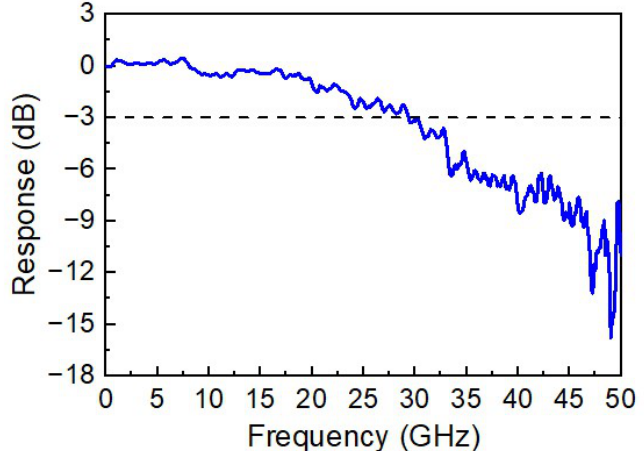
Figure 6. Small-signal modulation response of the EML laser when the DFB current was 70 mA and the bias voltage of the modulator was −2 V. the bias voltage of the modulator was − 2